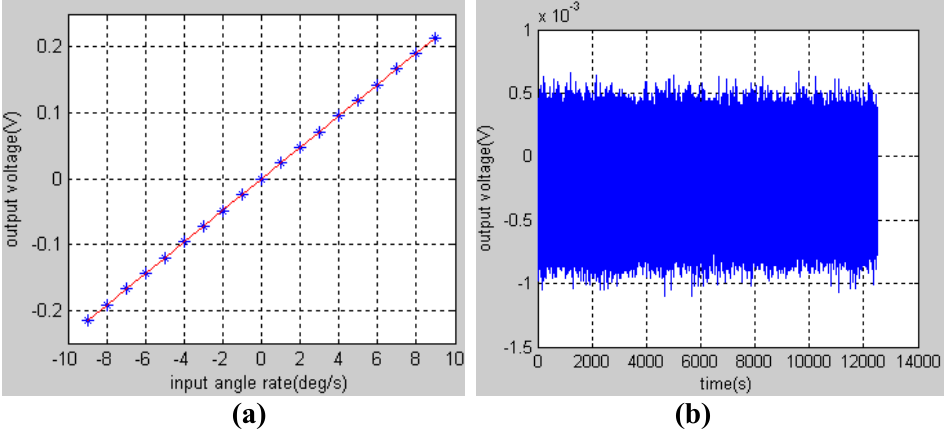
Figure 7. (a) The fitting curve of the test data. (b) Original data of gyroscope output in static